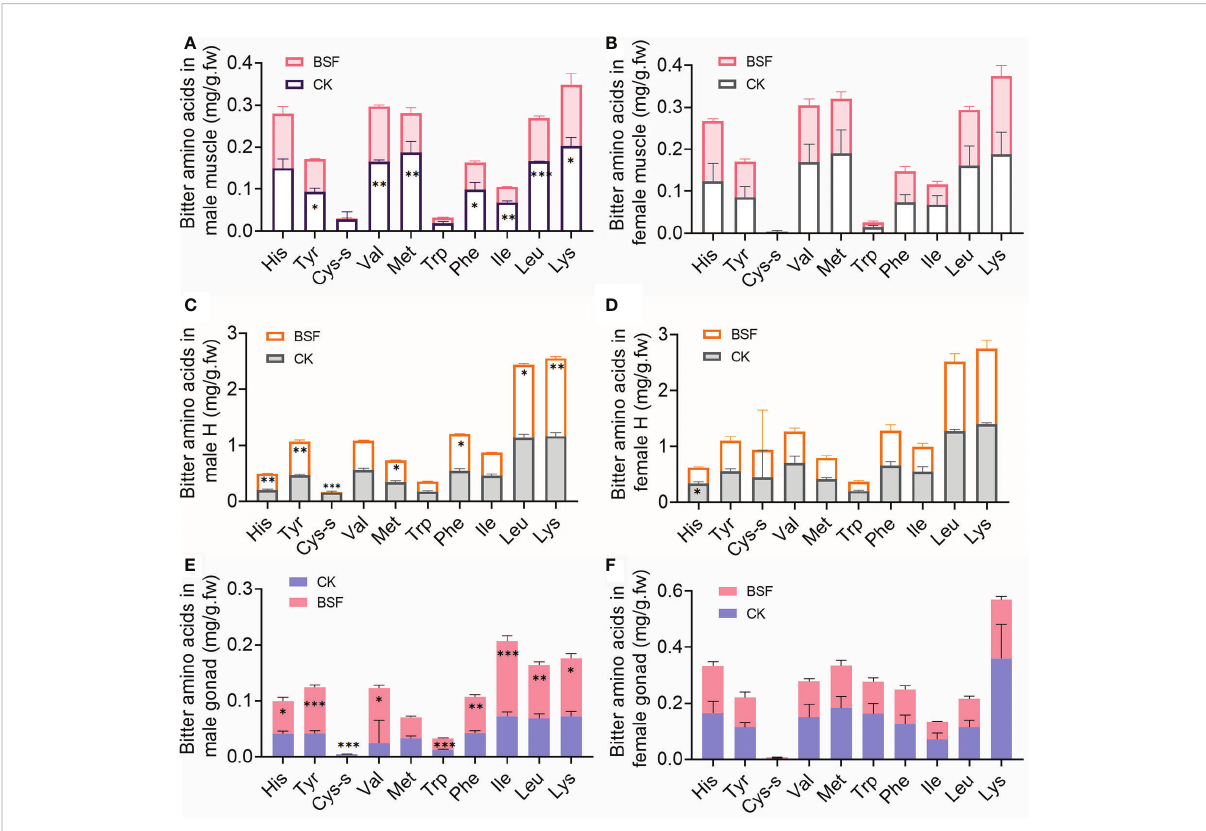
FIGURE 3 Effects of BSFL feeding on bitter amino acid levels in edible tissues of mitten crabs. Bitter amino acid levels in male and female muscles (A, B) , hepatopancreas (C, D) , and gonads (E, F) . CK, control group; BSF, experimental group. H, hepatopancreas; His, histidine; Tyr, tyrosine; Cys-s, cysteine-s; Val, valine; Met, methionine; Trp, tryptophan; Phe, phenylalanine; Ile, isoleucine; Leu, leucine; Lys, lysine. * P ≤ 0.05; ** P ≤ 0.01; *** P ≤ 0.001. n =